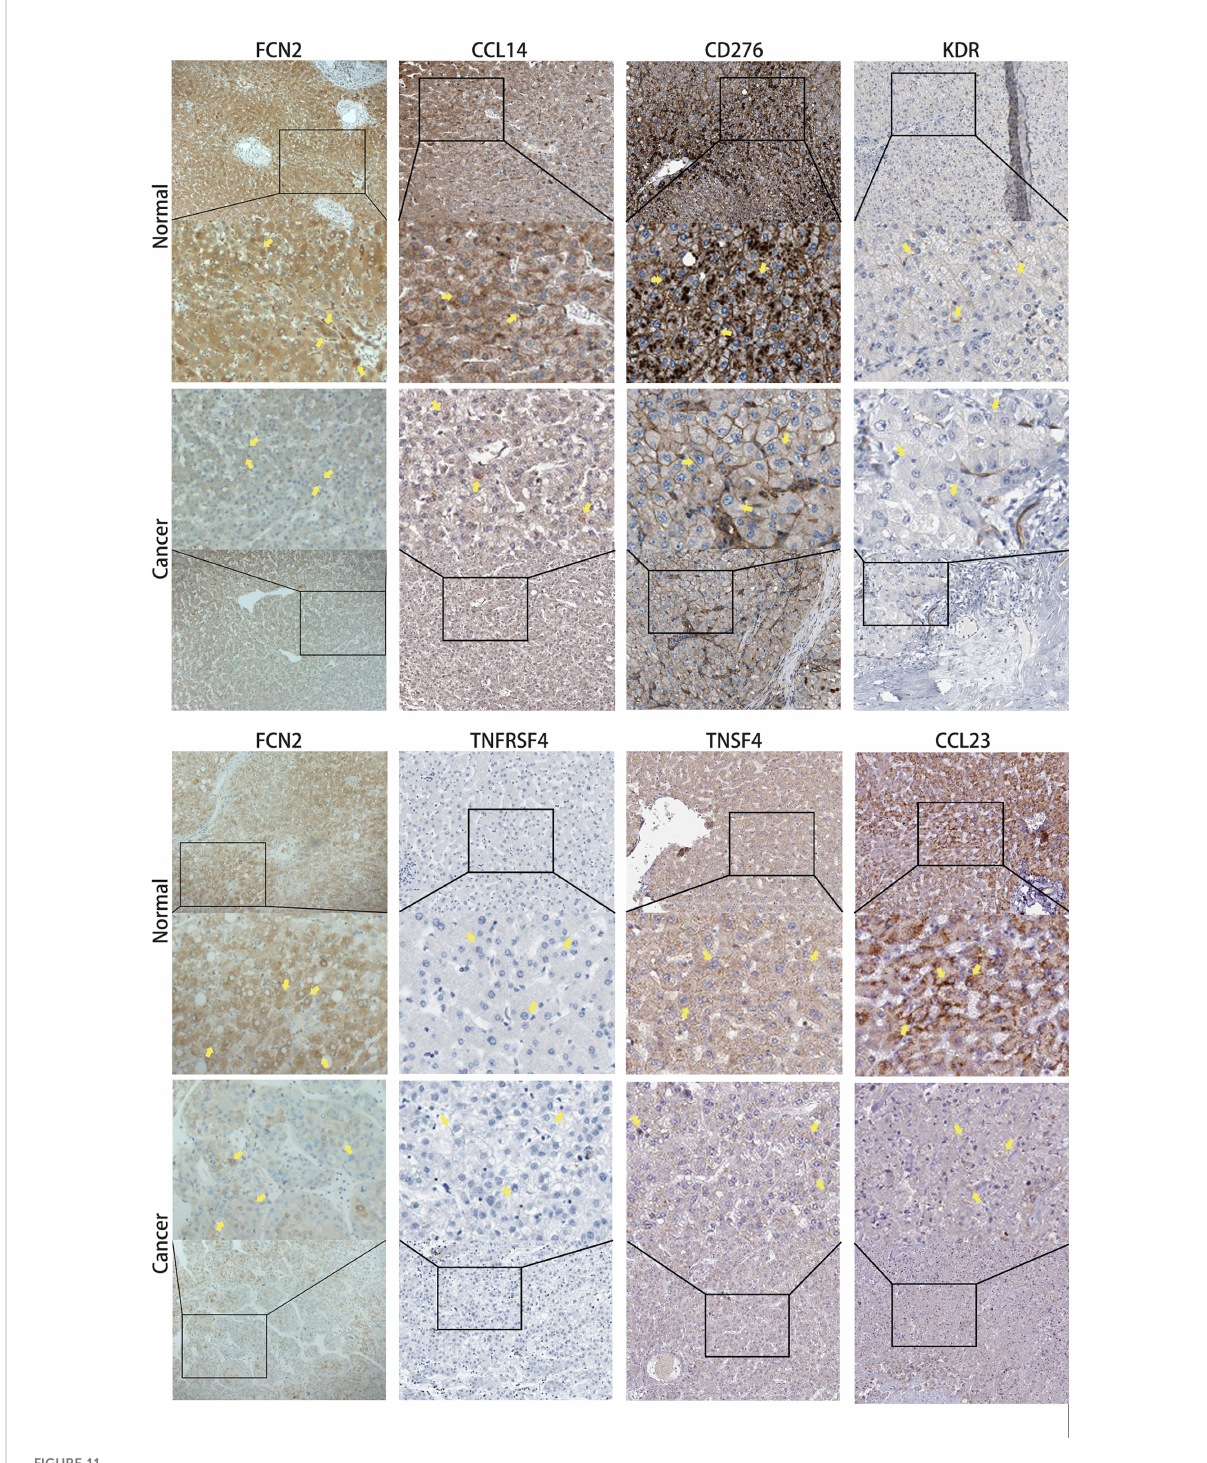
FIGURE 11 Immunohistochemical comparison of FCN2 and the molecules with strong correlations [based on the Human Protein Atlas